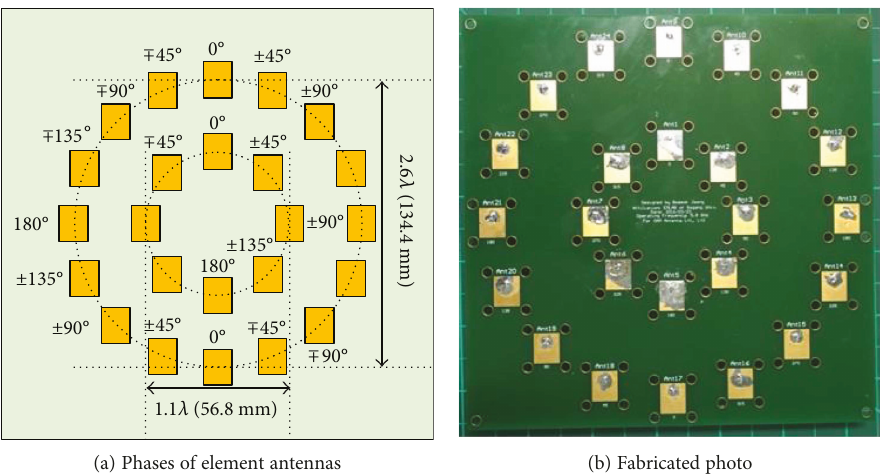
Figure 1: Circular array antennas for generation of OAM modes L =1 and 2.